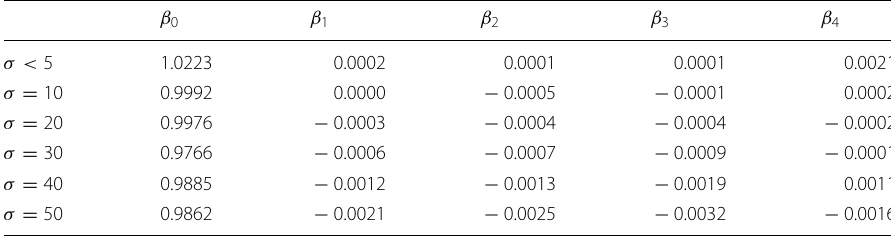
Table 1 The learned { β k } for depth images with different levels of noise